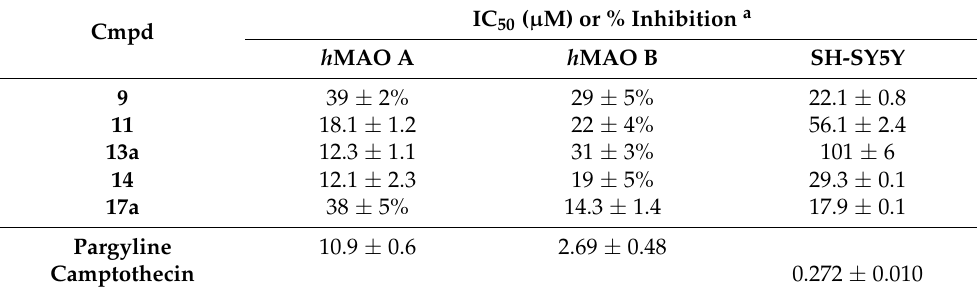
Table 3. Inhibitory activity on human MAO A and MAO B and the cell viability of SH-SY5Y neuronal cells by selected DHPPIQ